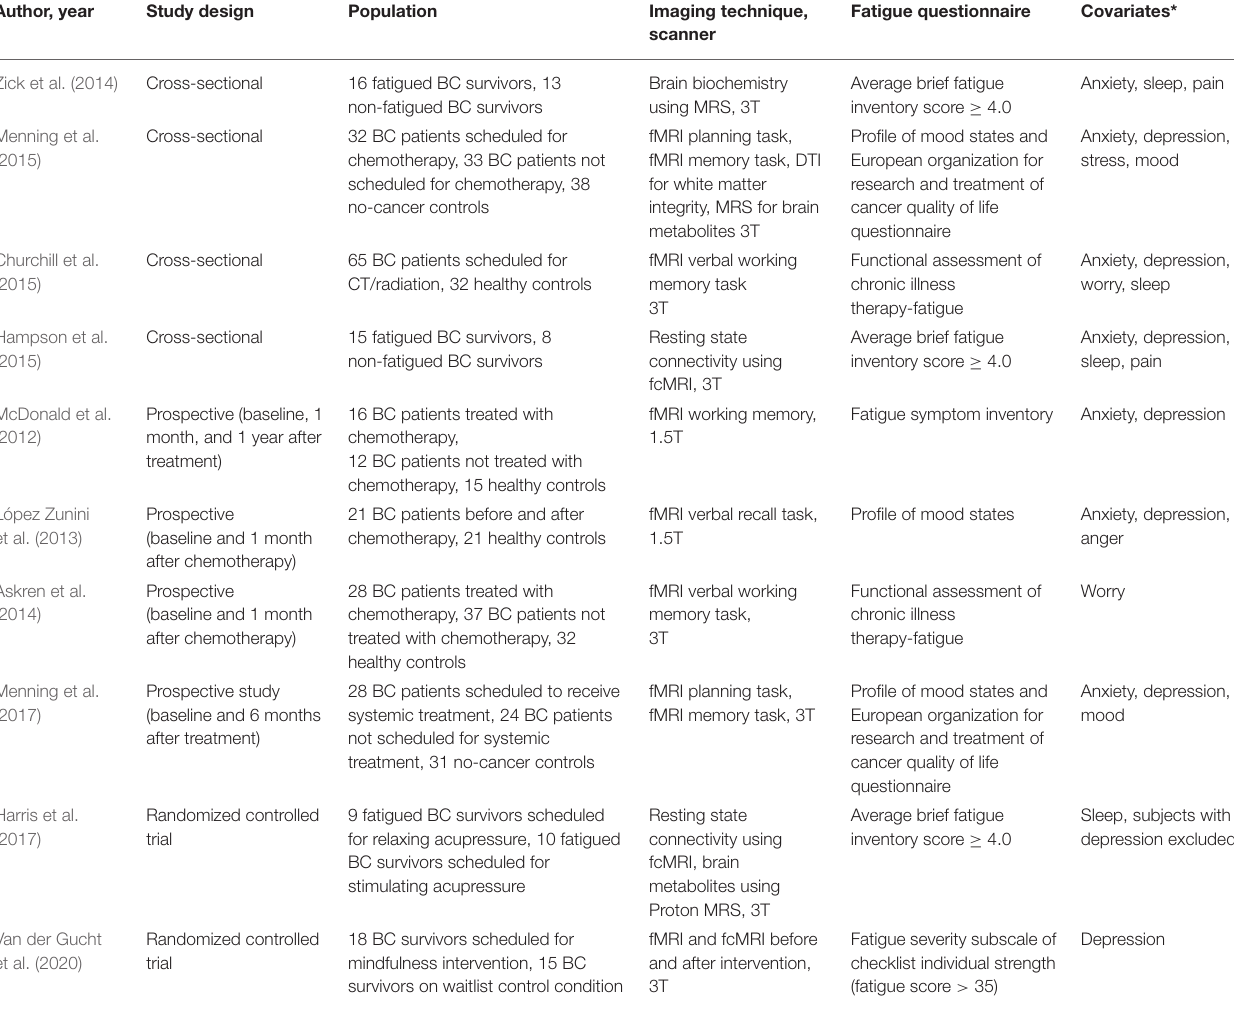
TABLE 1 | Neuroimaging studies that used MRI to evaluate neural mechanisms of breast cancer related